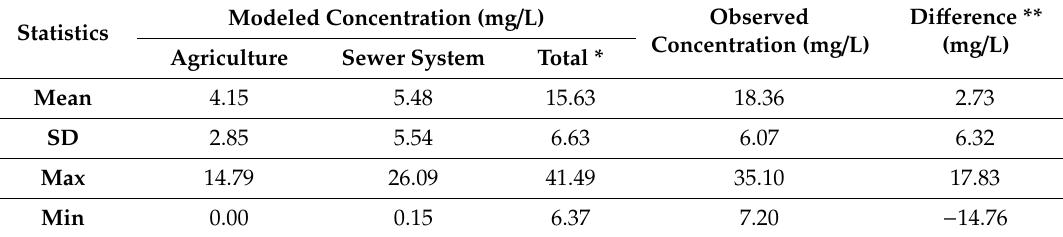
Figure 8. The spatial distribution of modeled compared to observed nitrate concentrations in groundwater. Table 4. Summary statistics for modeled and observed nitrate concentrations at observation locations (Table